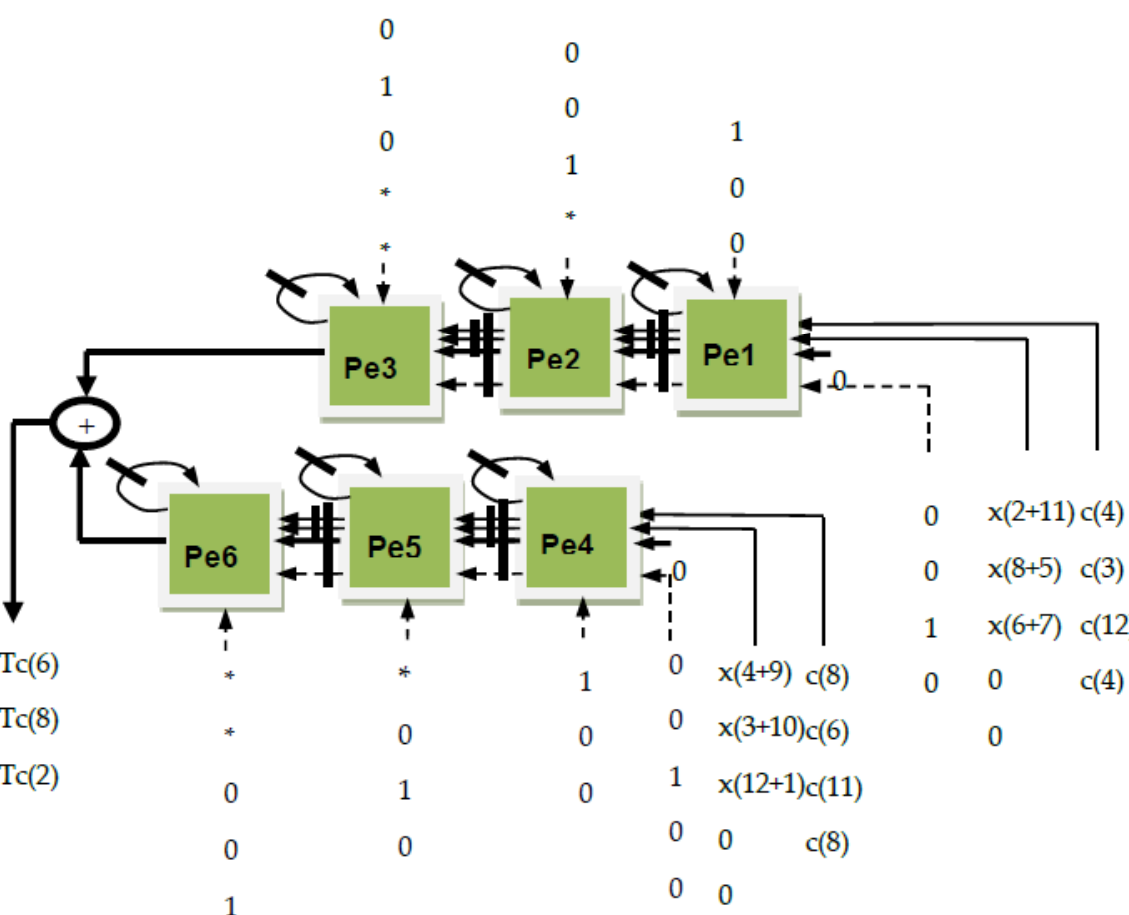
Figure 2. The VLSI architecture of the hardware core that implements Equation (9), where * marks a delay of one clock cycle [26].